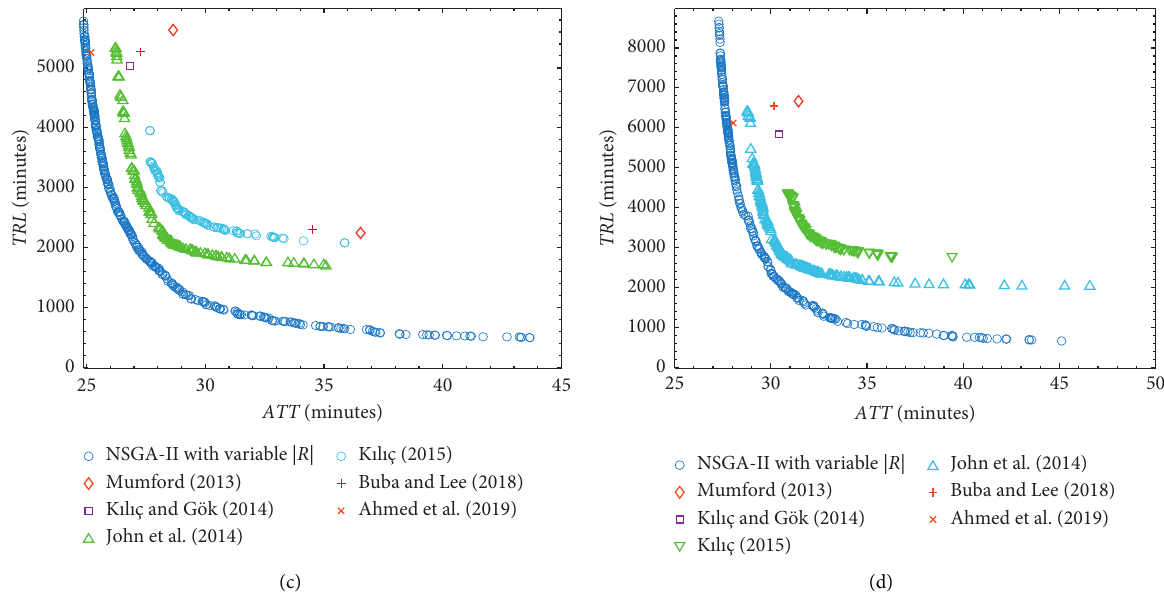
Figure 11: Comparison with previously published results for Mumford’s networks. (a) Mumford0. (b) Mumford1. (c) Mumford2. (d) Mumford3. Table 10: Passenger perspective results compared to other approaches for Mumford’s networks.